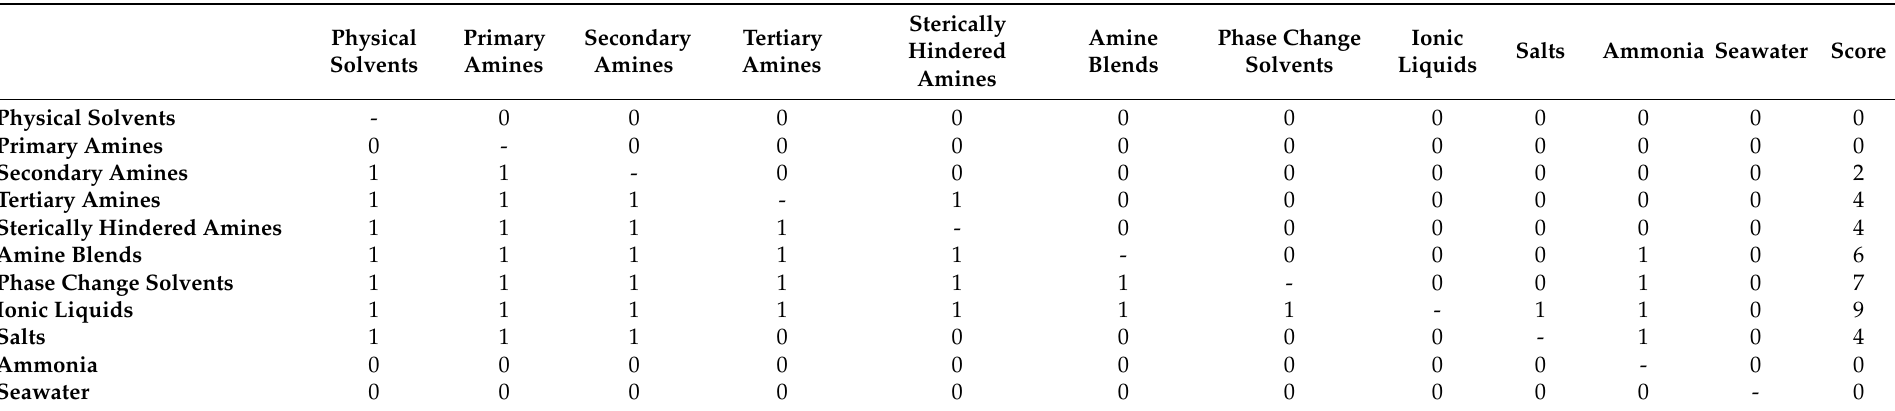
Table 5. Multi-objective assessment of the considered solvents using the KPIs with a criticality range of I and assuming the same maturity